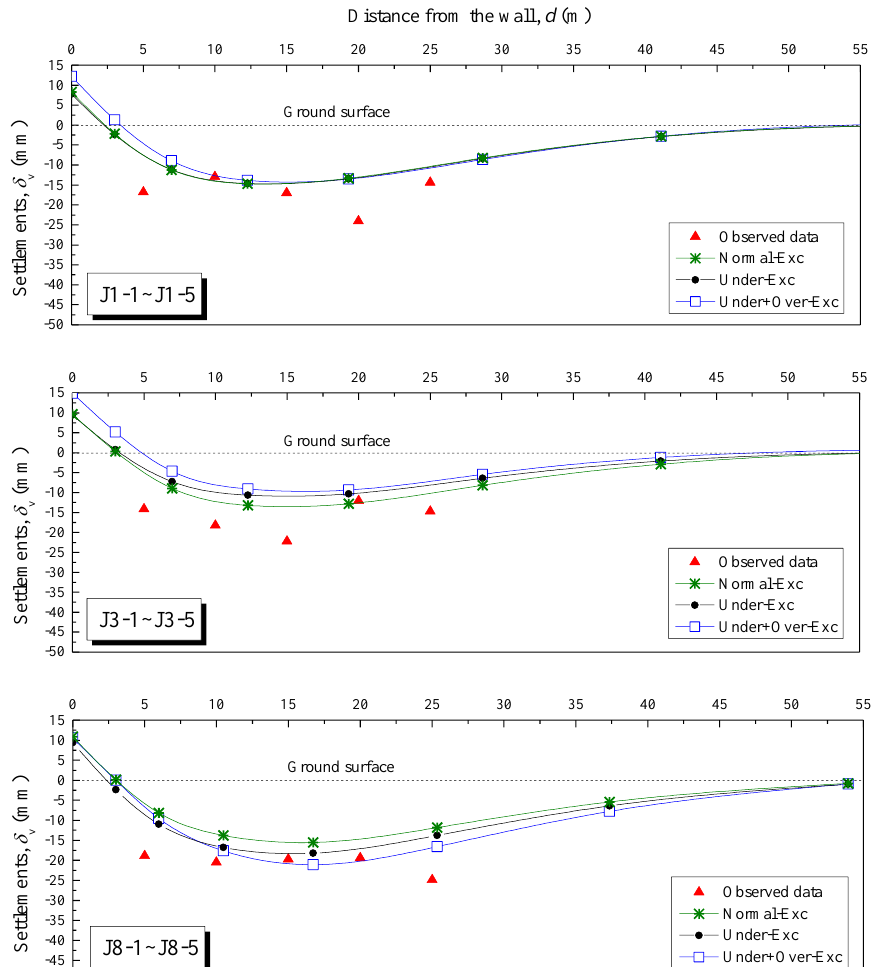
Figure 24. Ground settlement troughs at J1, J3, and J8.